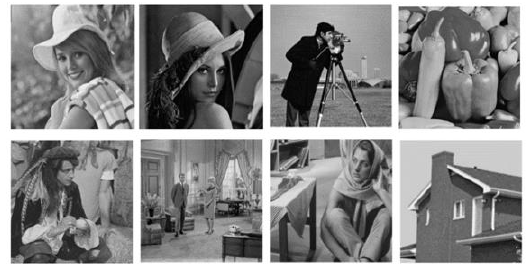
Figure 4. Standard gray level test images used for